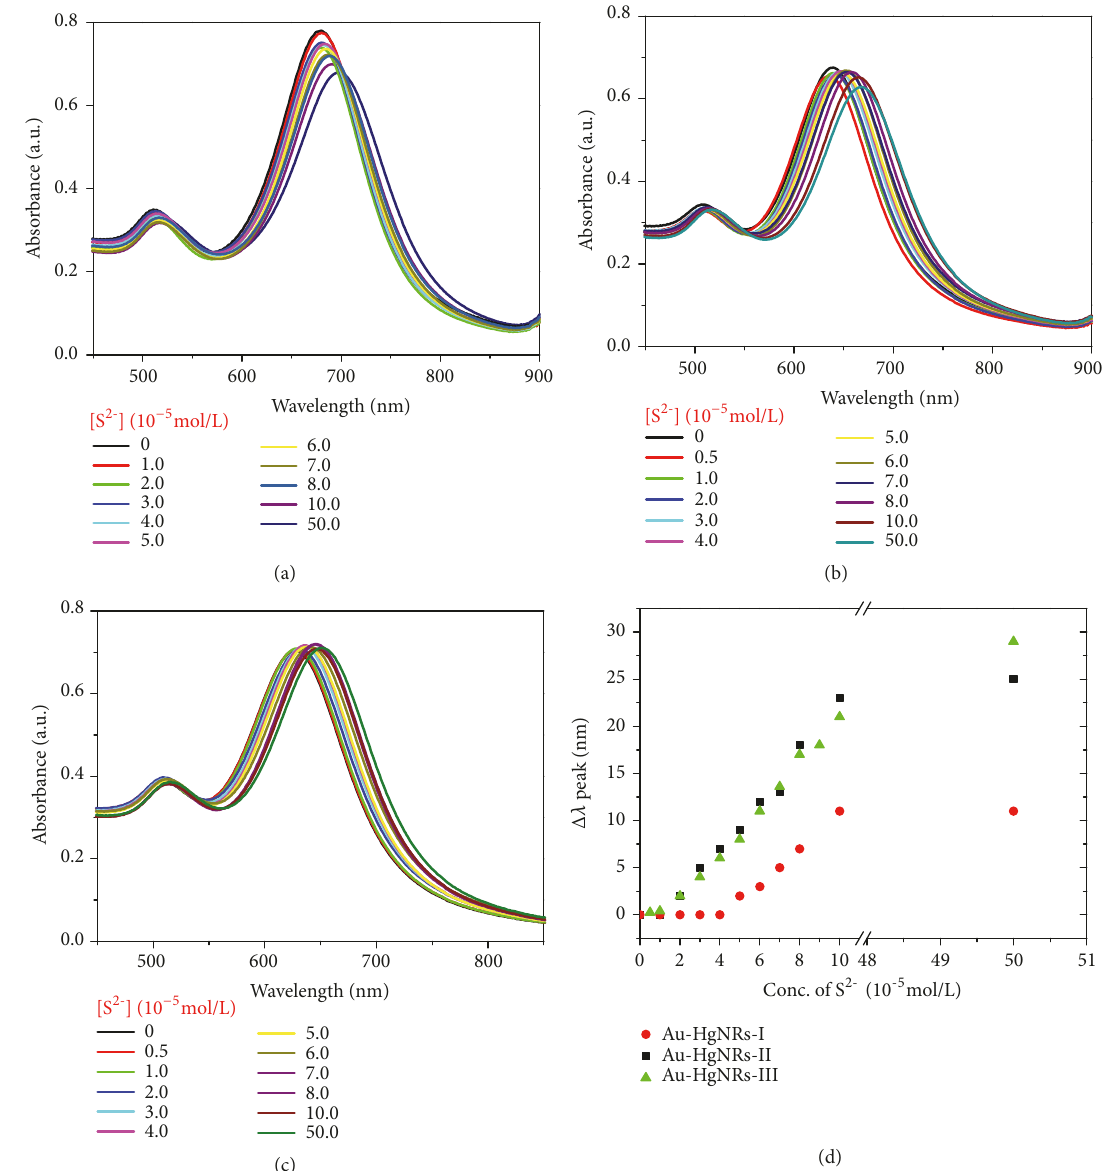
Figure 4: UV-vis absorption spectra of (a) Au-HgNRs-I, (b) Au-HgNRs-II, and (c) Au-HgNRs-III solutions containing different concentrations of S 2− ; (d) variation plots of shifts in LSPR peak wavelength ( Δ𝜆 ) against the concentration of S 2−